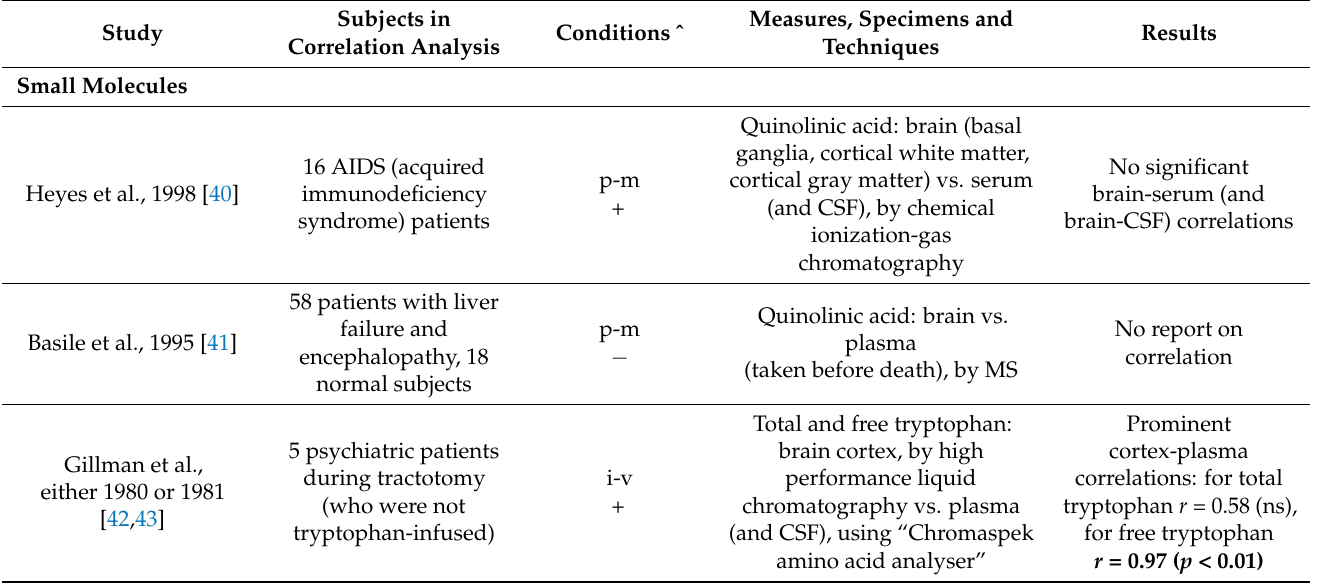
Table 1. Eligible